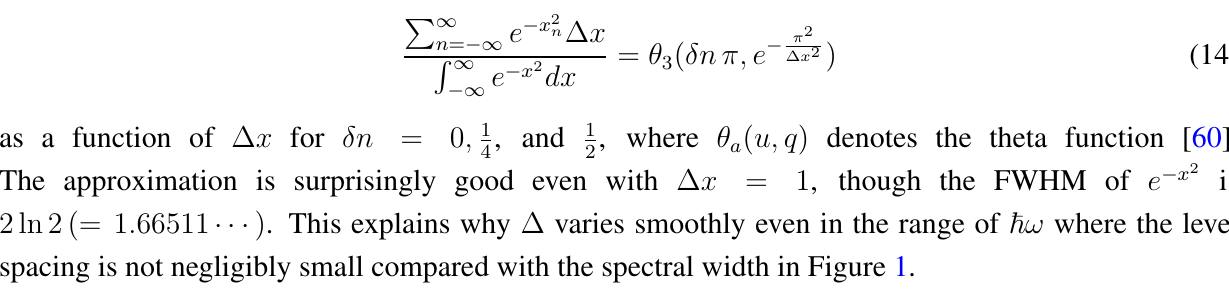
Figure 5. Ratio given by Equation (14) as a function of ∆ x for different offset values δn